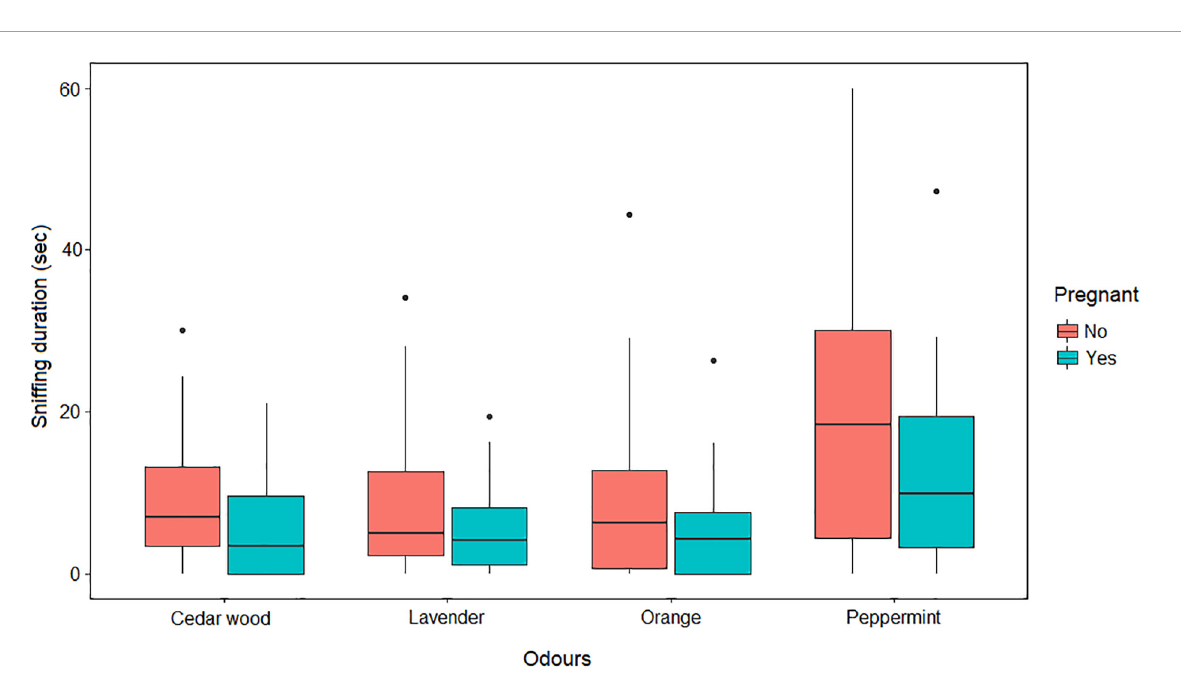
FIGURE5 Illustration of sniffing duration (seconds) per odor (orange, peppermint, lavender and cedar wood), divided by pregnant (blue) and non-pregnant (red) females. The boxes represent the 25, and 75% quartiles, the thick line inside the box represent the median and the vertical error bars illustrate the